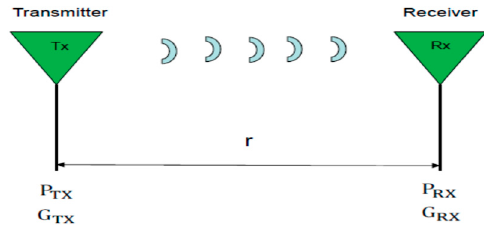
Figure 1. Basic power transfer between transmitter and receiver of antenna.